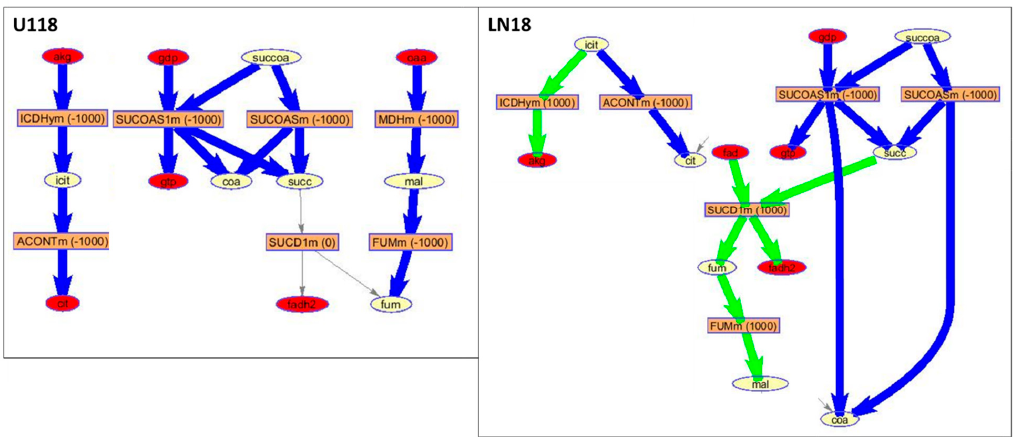
Figure 8. Part of the TCA-cycle-related metabolic processes. GIMME calculated fluxes in LN18 and U118 EVs made possible based on previously determined proteins in these vesicles. GIMME analysis provides a flux model with a minimized use of low-expression reactions while maximizing the objective reaction, in this case biomass preservation. Reactions are shown using the modeldraw.rxns routine in COBRA running under Matlab. Excluded from the representation are the cofactors including CO 2 , H 2 O, ATP, ADP, NAD, NADH, NADPH, NADP, H, Pi. In the figure, rectangles represent reactions with rates of fluxes in parentheses; ellipses represent metabolites; the red ellipses represent dead-end metabolites; gray arrows represent zero-rate fluxes; green arrows represent positive-rate (forward) fluxes; and blue arrows represent negative-rate (backward) fluxes. Reactions and metabolites notation is based on the Recon 3 metabolic network and is: akg—oxoglutarate (a-ketoglutarate), icit—isocitrate, cit—citrate, succ—